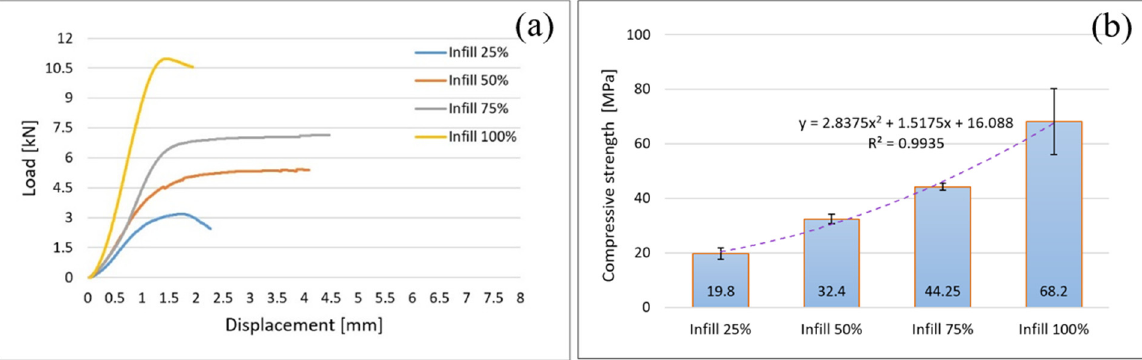
Figure 5. Compression test results for samples with rectangular cross-section; ( a ) load—displacement curves; ( b ) relationship between infill density and compression strength.